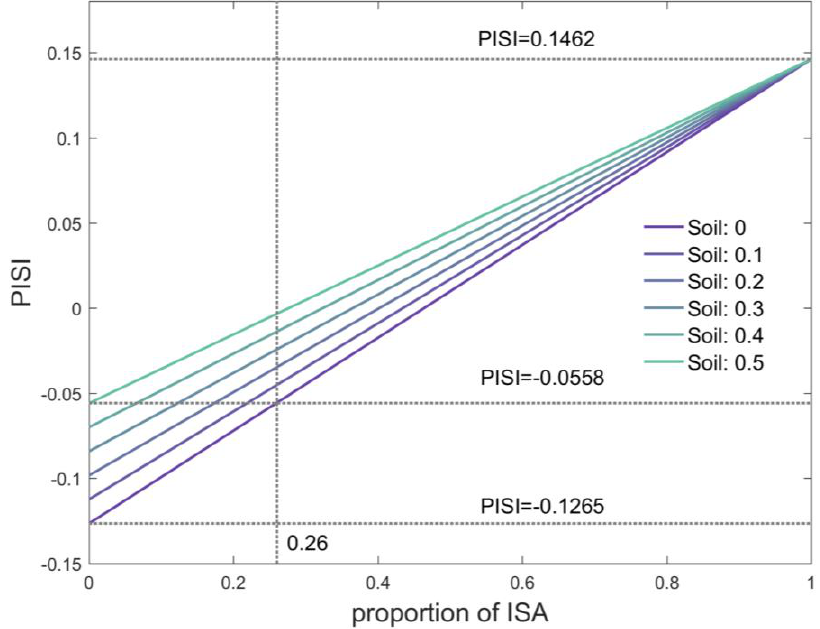
Figure 9. Relationship between PISI value and proportion of ISA in six simulation cases.